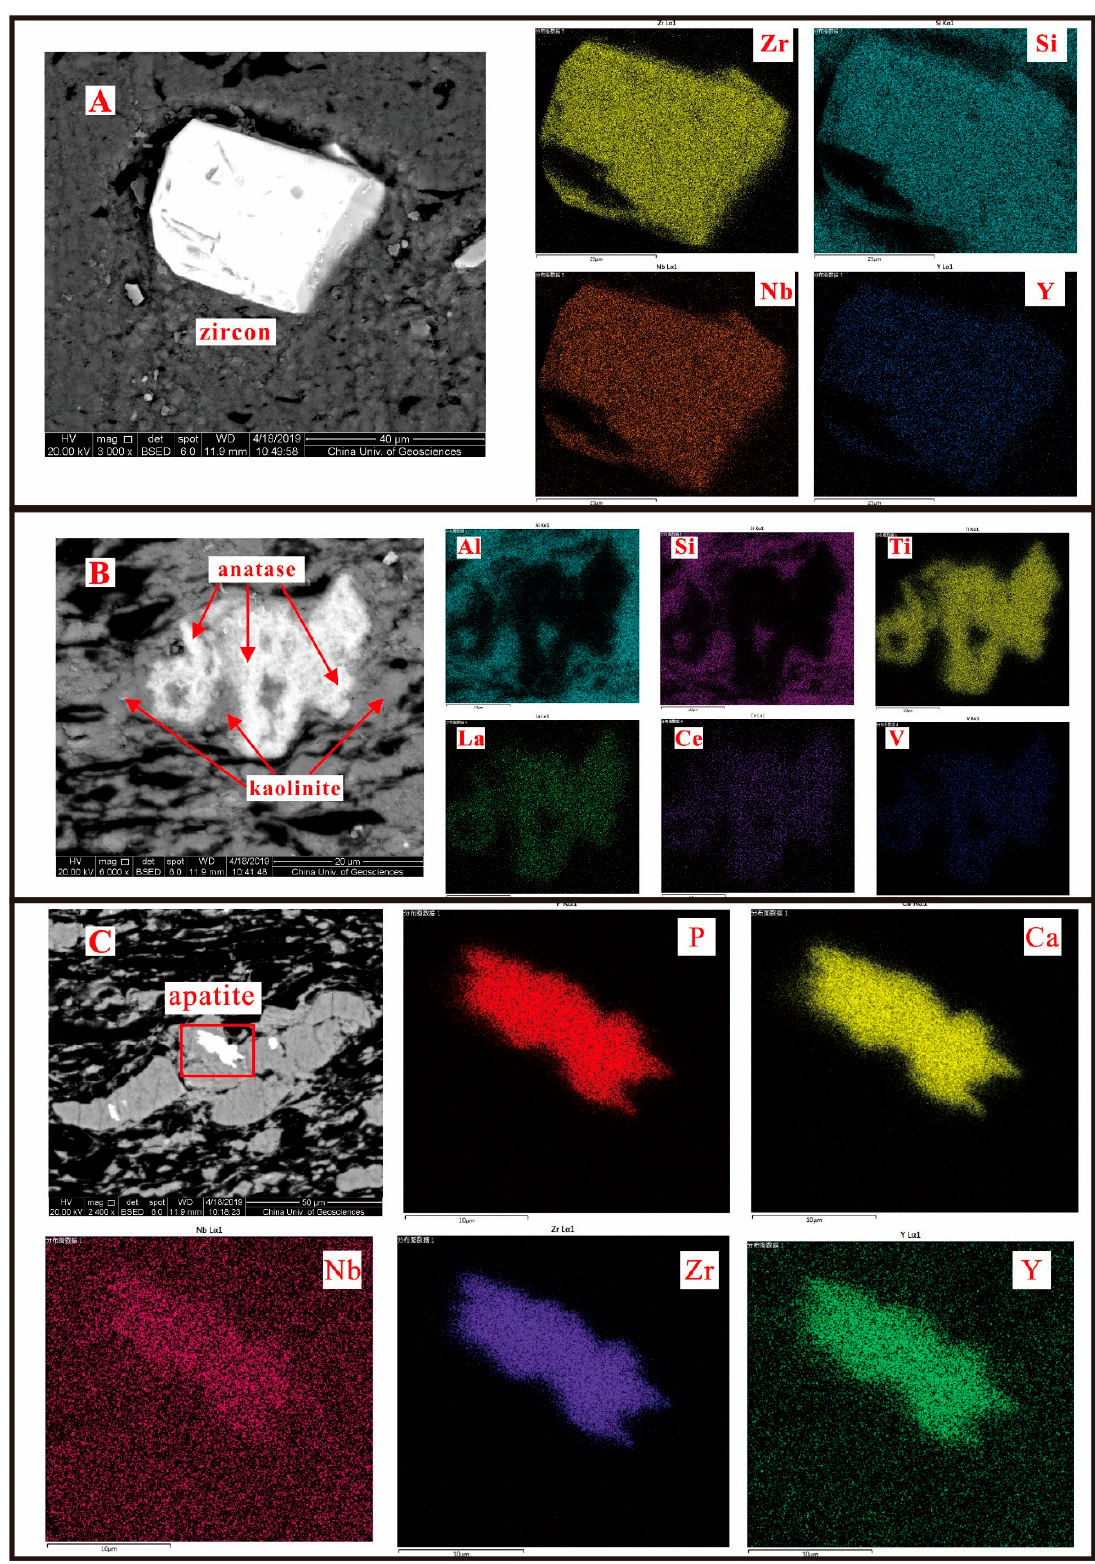
Figure 8. SEM-EDS mappings of zircon ( A ), anatase ( B ), and apatite( C ) in the parting sample PR-4-4.